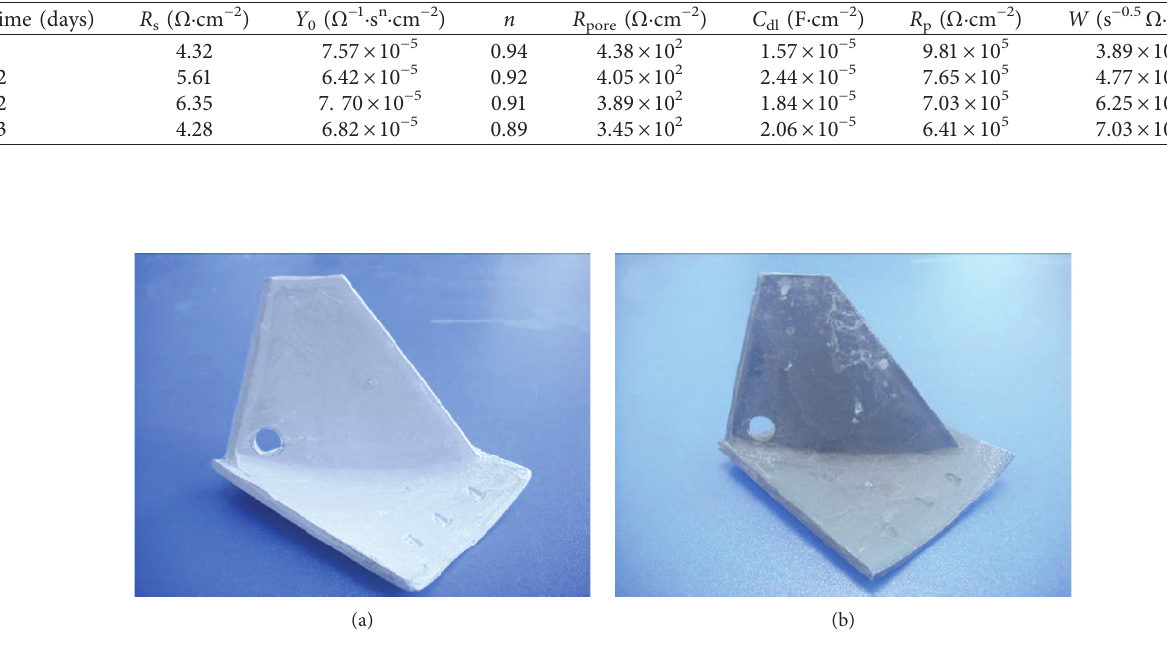
Figure 13: Surface morphology of the (a) MAO coating and (b) anodic oxidation coating after the salt spray